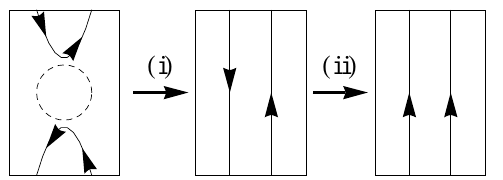
Figure 4: Creation of two opposite winding loops after the flip of the dashed loop (i) and insertion of flux after the flip of the winding loop